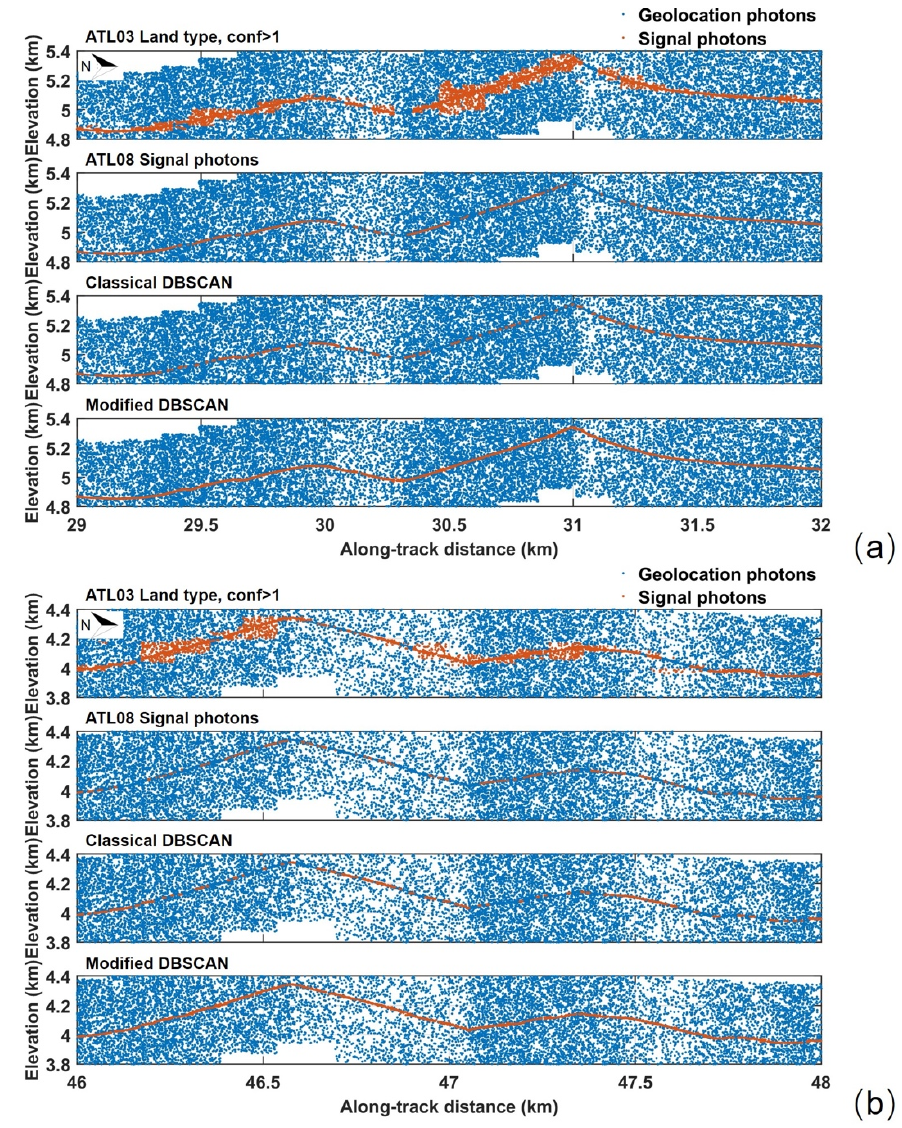
Figure 10. Detailed comparison of results from different signal photon extraction methods in the first study area. The rows from top to bottom correspond to signal photon extraction results from the ATL03 dataset, the ATL08 dataset, the classical DBSCAN algorithm, and the modified DBSCAN algorithm, respectively. The measured geolocated photons are drawn with blue points while the extracted signal photons are marked with red points. ( a ) Enlarged along-track segment corresponding to the yellow box in Figure 9a at the along-track distance from 29 km to 32 km. ( b ) Enlarged along-track segment corresponding to the green box in Figure 9a at the along-track distance from 46 km to 48 km.